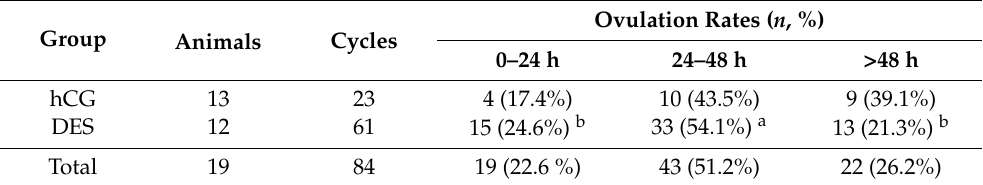
Table 6. Distribution of ovulations (0–24 h, 24–48 h, >48 h) after the administration of human chorionic gonadotropin (hCG) and deslorelin acetate (DES) in jennies. Ovulation Rates ( n , %) Group Animals Cycles 0–24 h 24–48 h >48 h hCG 13 23 4 (17.4%) 10 (43.5%) 9 (39.1%) DES 12 61 15 (24.6%) b 33 (54.1%) a 13 (21.3%) b Total 19 84 19 (22.6 %) 43 (51.2%) 22 (26.2%)